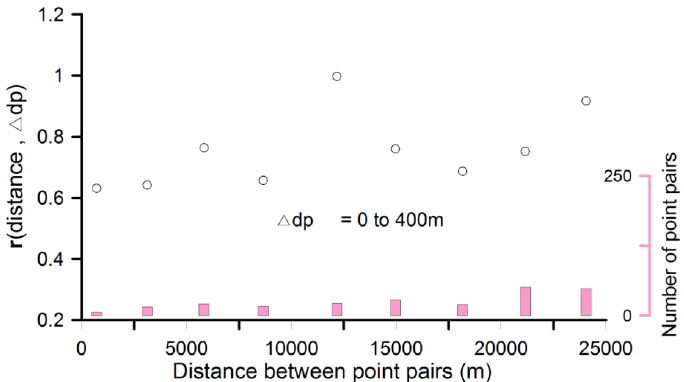
Figure 8. Experimental distance/relative-depth-based variogram for data on single seamount (77 surveying samples on guyot Mk , shown in Table 1), with a relative-depth interval of 0–400